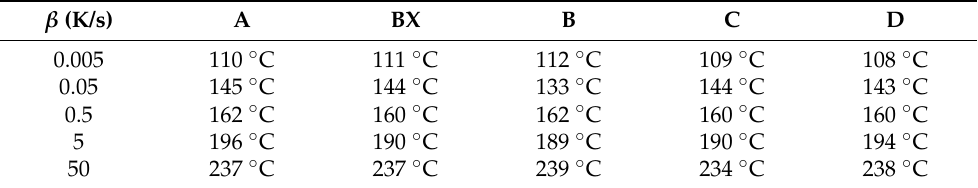
Table 2. Temperatures corresponding to inflection points ( T i) at different heating rates ( β ) for stage I of tempering in the dilatometry data.